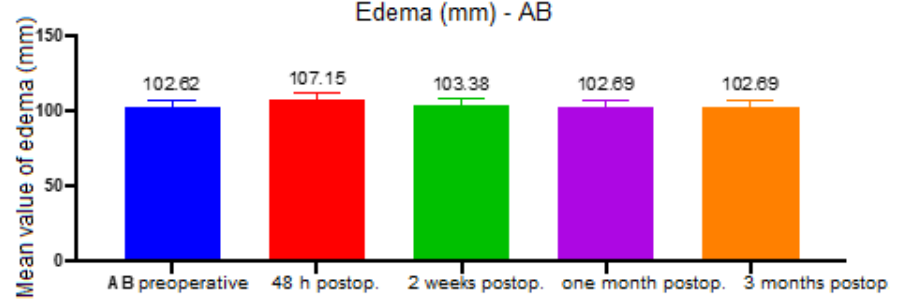
Figure 4. Edema assessment, AB distance.